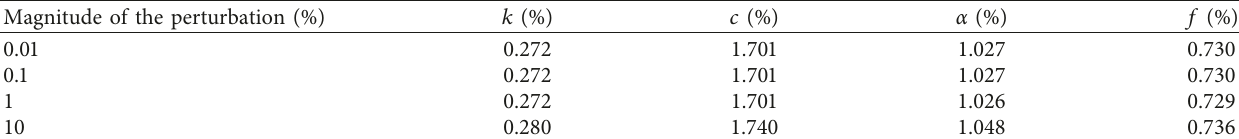
Table 7: Identified errors with different magnitudes of the perturbation of the